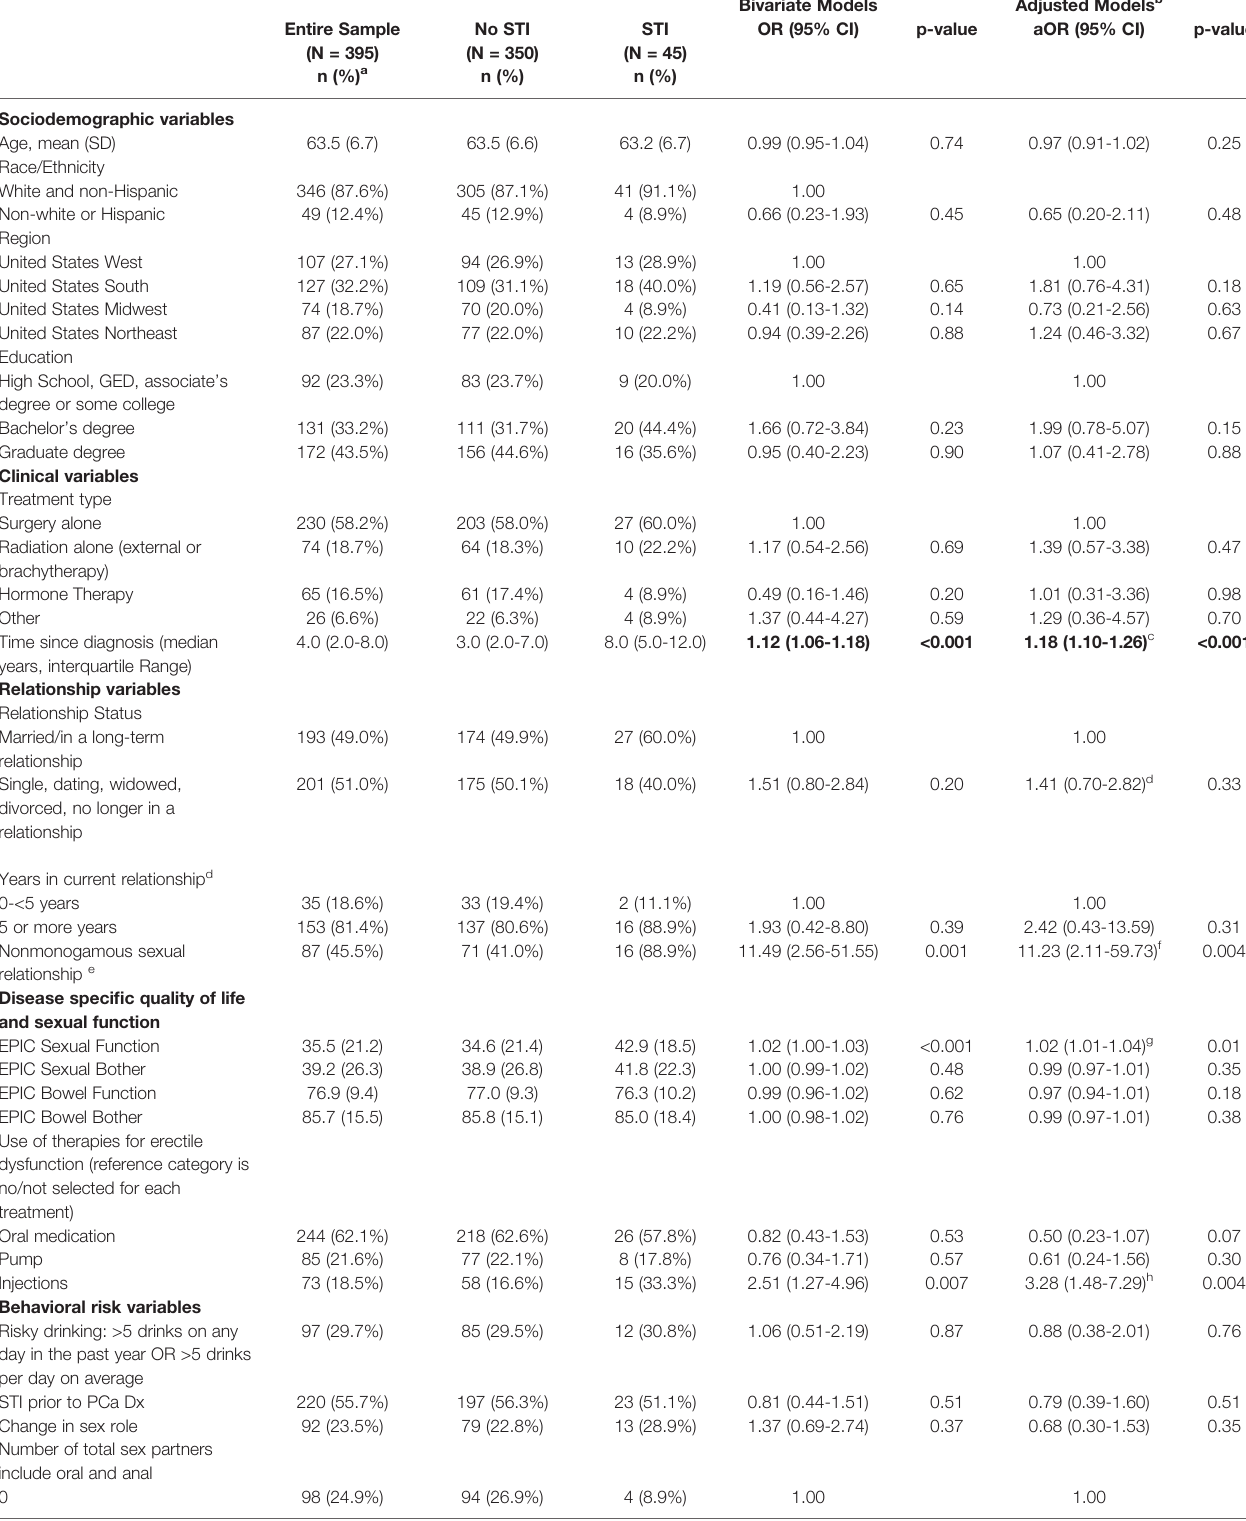
TABLE 1 | Correlates of acquiring sexually transmitted infection (STI) post prostate cancer treatment among gay and bisexual men (N =